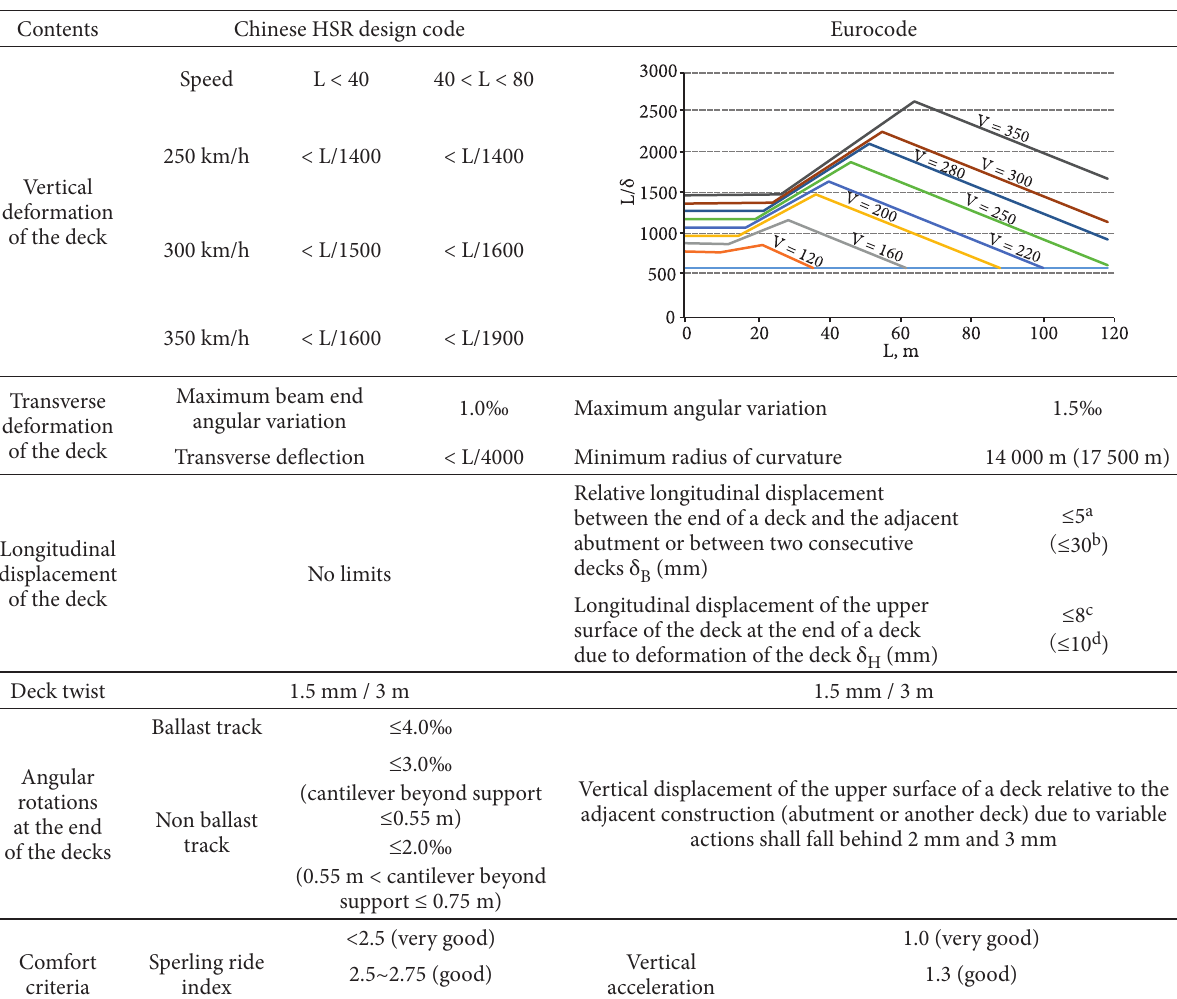
Table 3. Main deformation limiting values in the Chinese HSR code and the Eurocodes